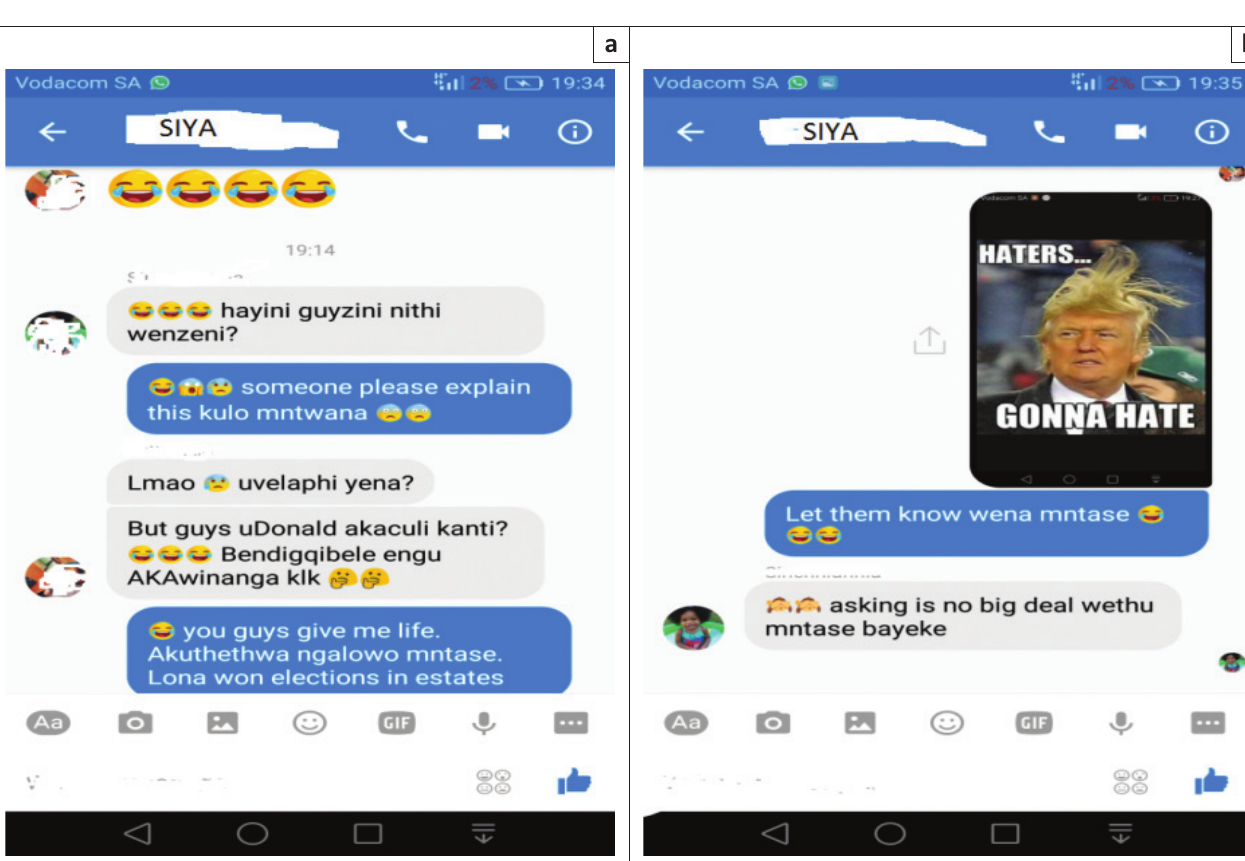
FIGURE 4: Screenshot example: (a) Online third discussion, and (b) online fourth